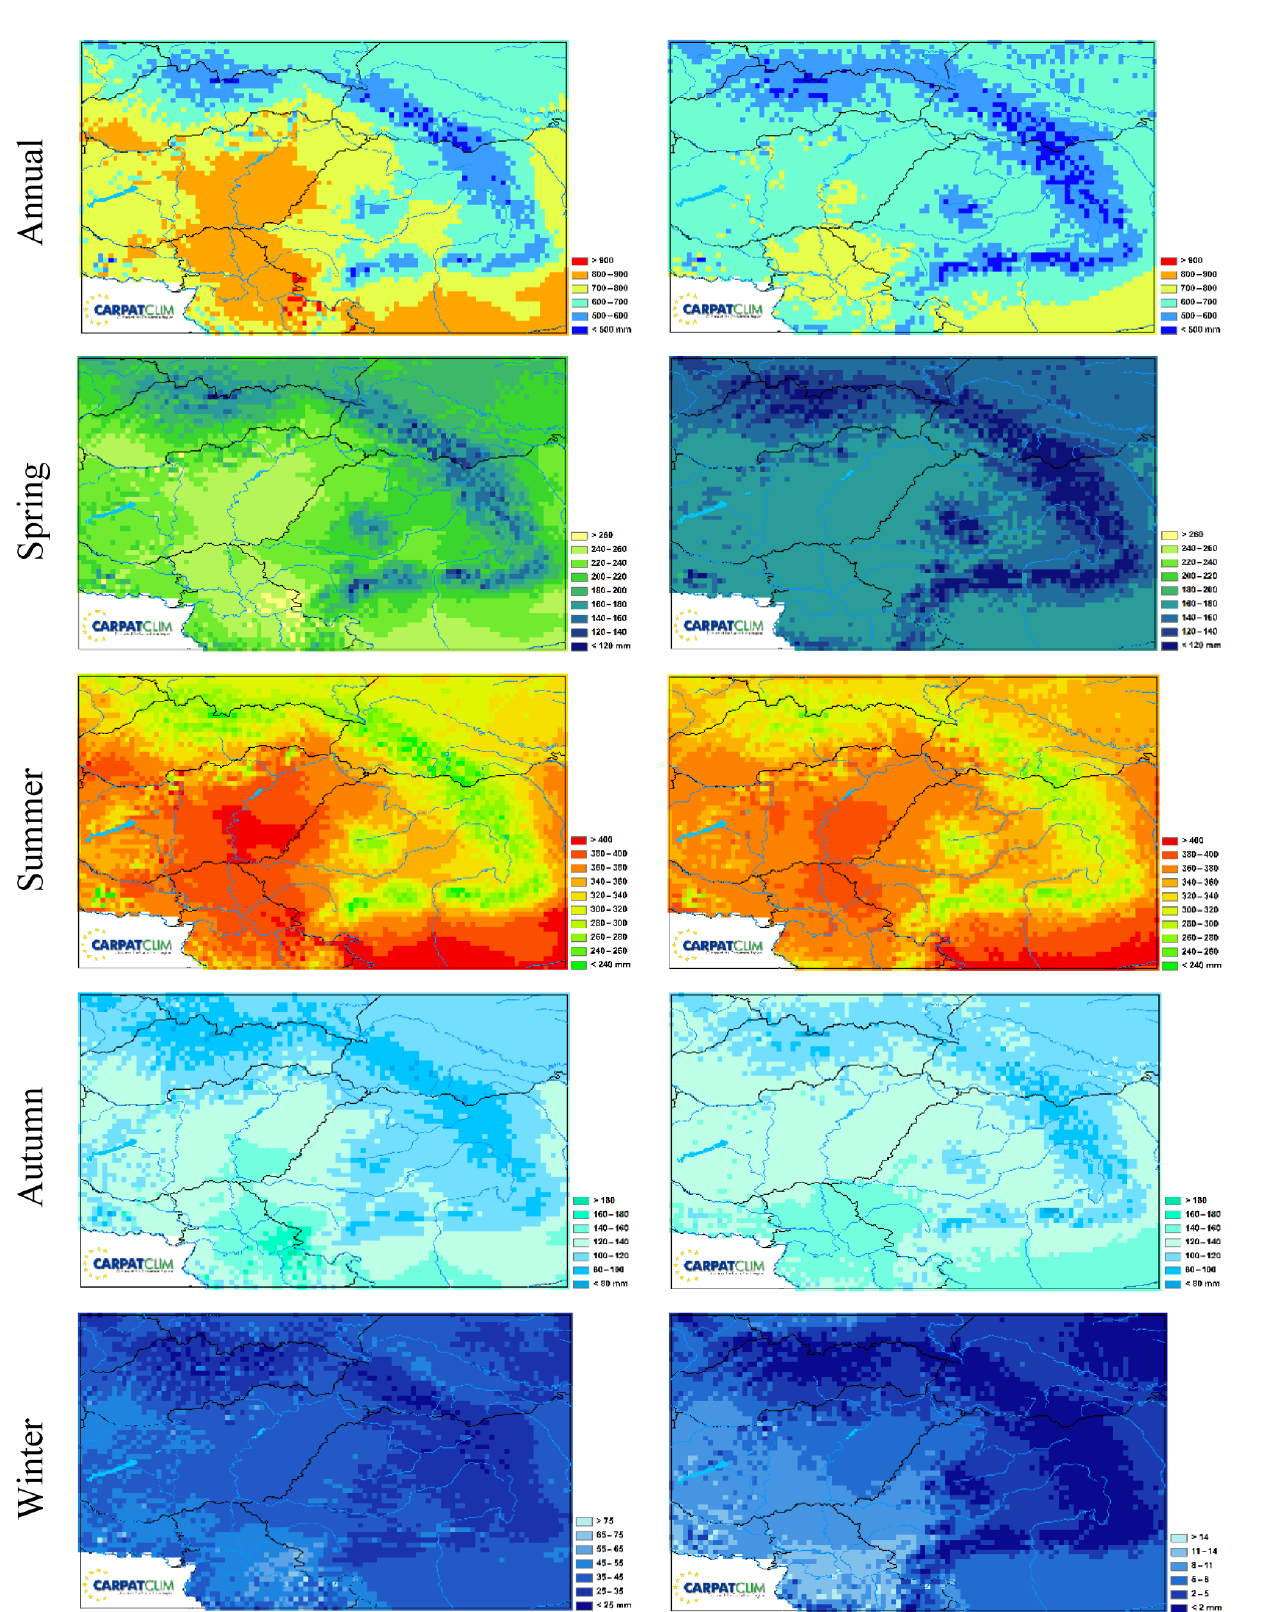
Figure 2. Annual and seasonal averages of ET 0 over the CarpatClim region from Penman–Monteith ET 0 (left panels) and Thornthwaite estimates (PET_Th) (right panels) for the period